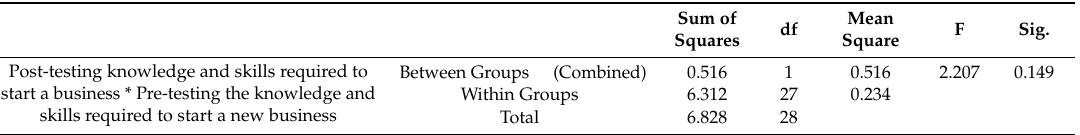
Table 7. Knowledge and Skills ANOVA Table for entrepreneurial classes.